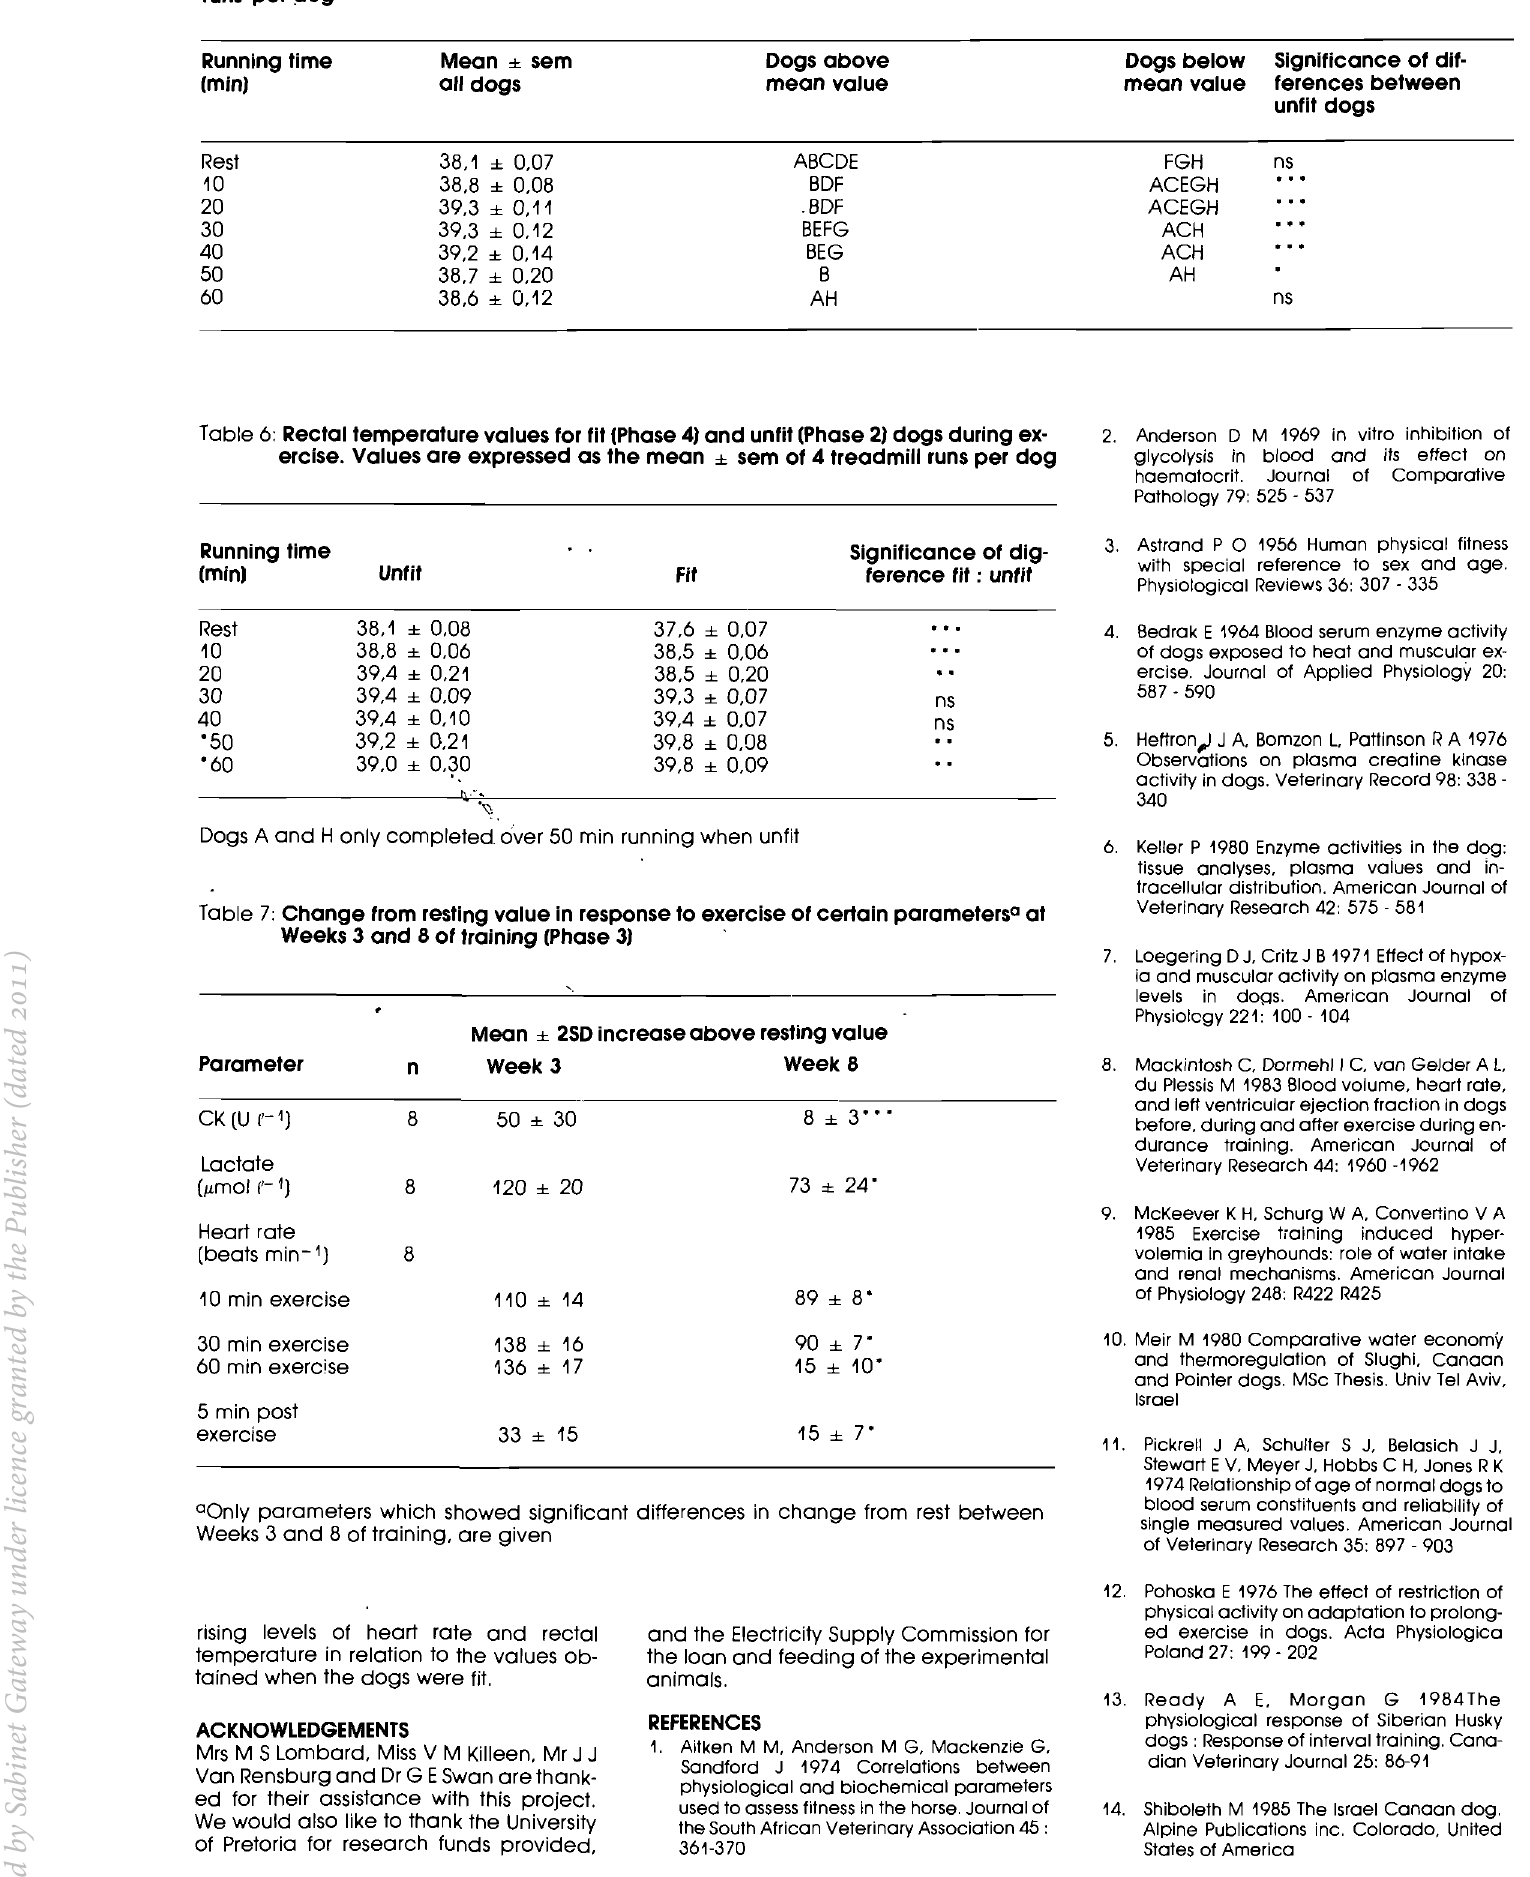
Table 6: Rectal temperature values for fit (Phase 4) and unfit (Phase 2) dogs during ex· ercise. Values are expressed as the mean ± sem of 4 treadmill runs per dog